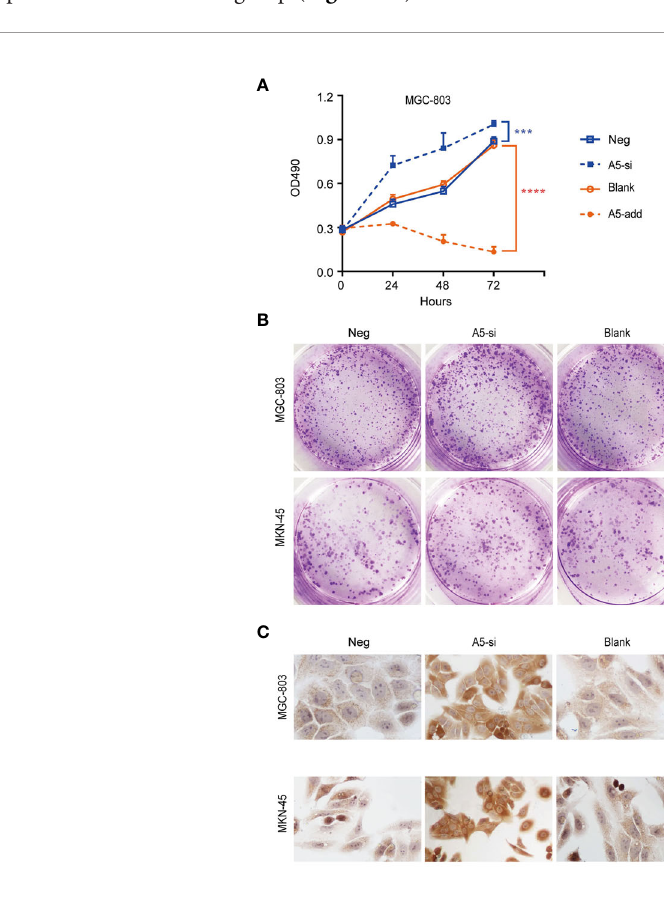
FIGURE 2 | ANXA5 regulated gastric cancer cell proliferation. The effects of ANXA5 on the proliferation of MGC-803 and MKN-45 cells were assessed by MTT assay and colony formation assay respectively. In the MTT experiment, subsequent to culture for 12, 24, 36, 48, and 72 h, the in vitro growth of the A5-si cells was signi fi cantly faster than that of the Neg group at all the time points ( P < 0.0001) while the A5-add group was much slower than that of the blank group (A) . Colony formation assay (B) which showed that the number of cell colony was signi fi cantly more in the A5-si group and less in the A5-add group ( P < 0.0001). PCNA expression was detected by immunohistochemistry with the results of increased expression in the A5-si group and decreased expression in the A5-add group (C) . * P < 0.01, *** P < 0.001, **** P <